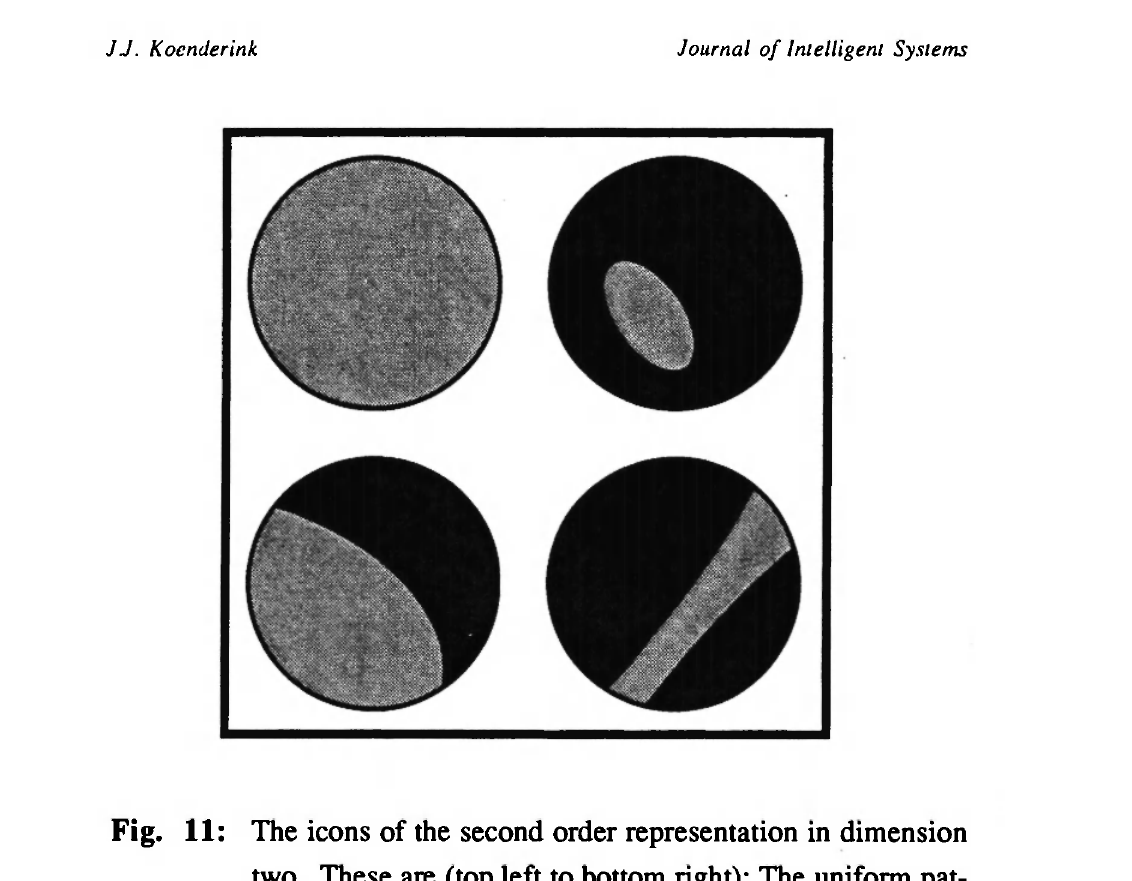
Fig. 11: The icons of the second order representation in dimension two. These are (top left to bottom right): The uniform pat- tern, the blob (light or dark, parameters position, ori- entation, eccentricity and area), the edge (parameters posi- tion, orientation and curvature) and the bar (light or dark, parameters position and orientation,